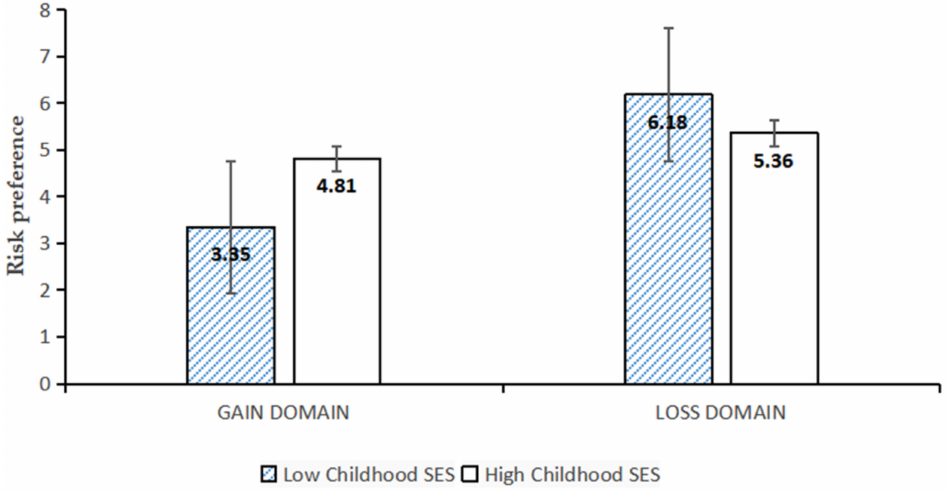
Figure 1. The effect of childhood SES on adolescents’ risk behaviors in gain and loss